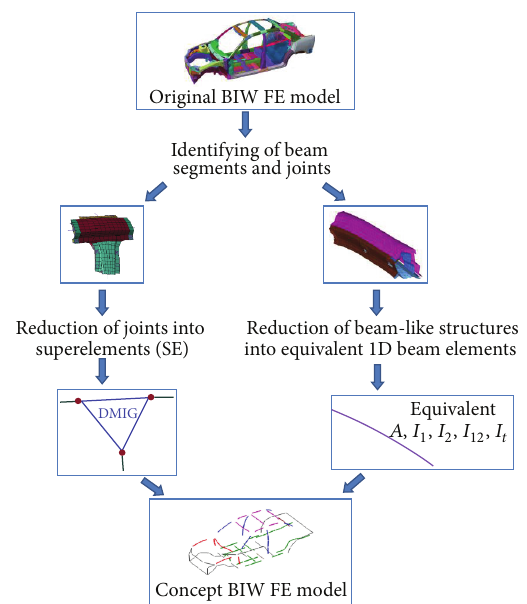
Figure 2: Workflow for the creation of beam and joint FE concept